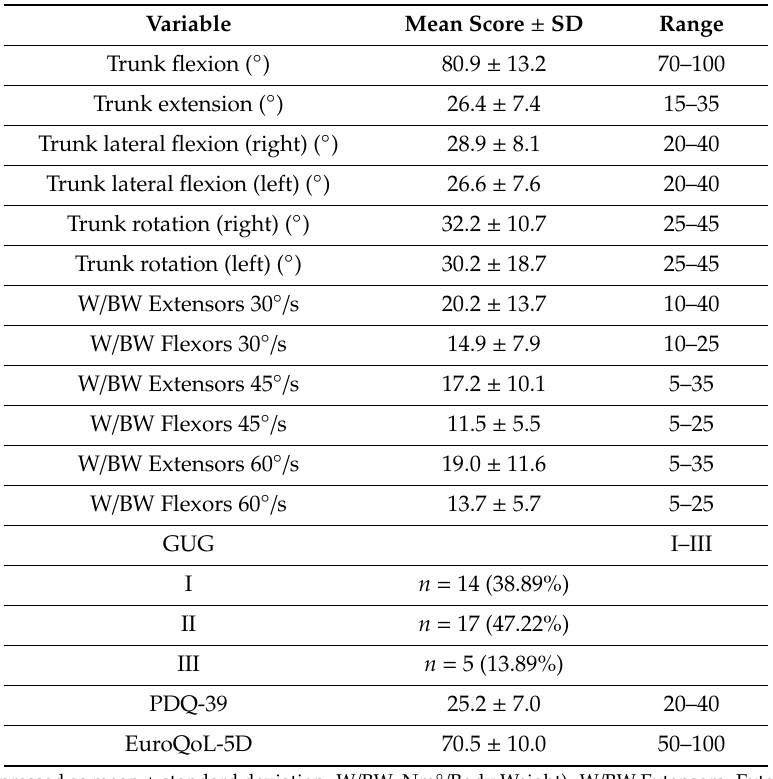
Table 2. Mean scores of trunk ROM, trunk rigidity, functional mobility and health related quality of life (HRQoL).